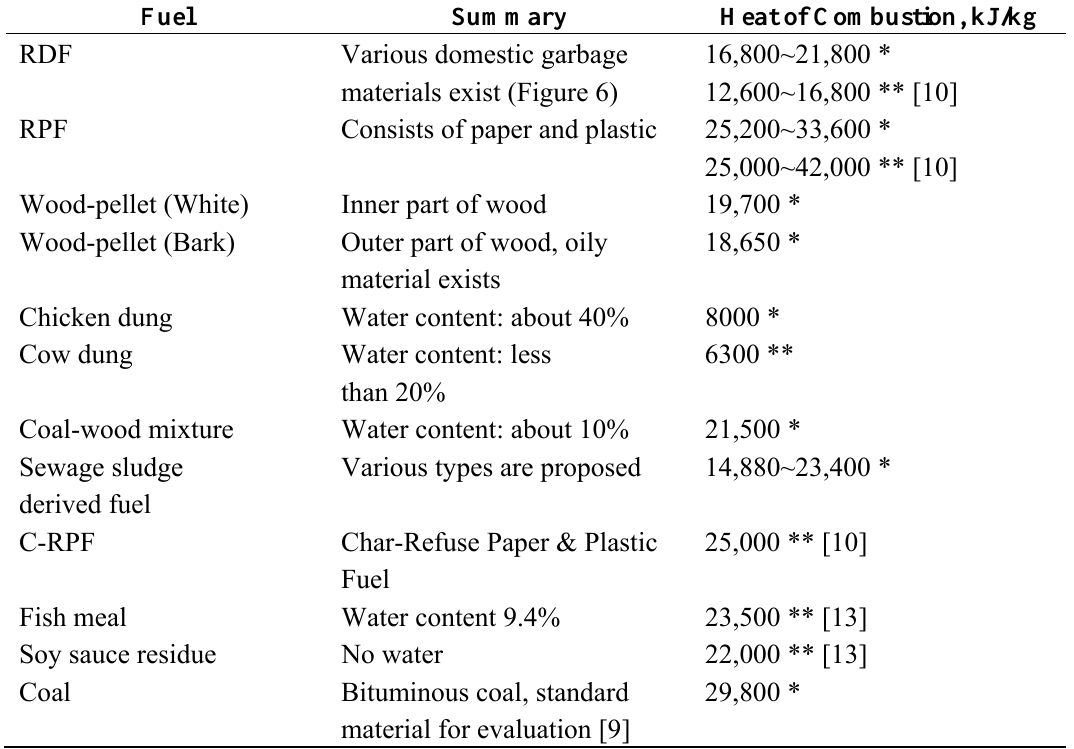
Table 2. Examples of biomass fuel and coal.